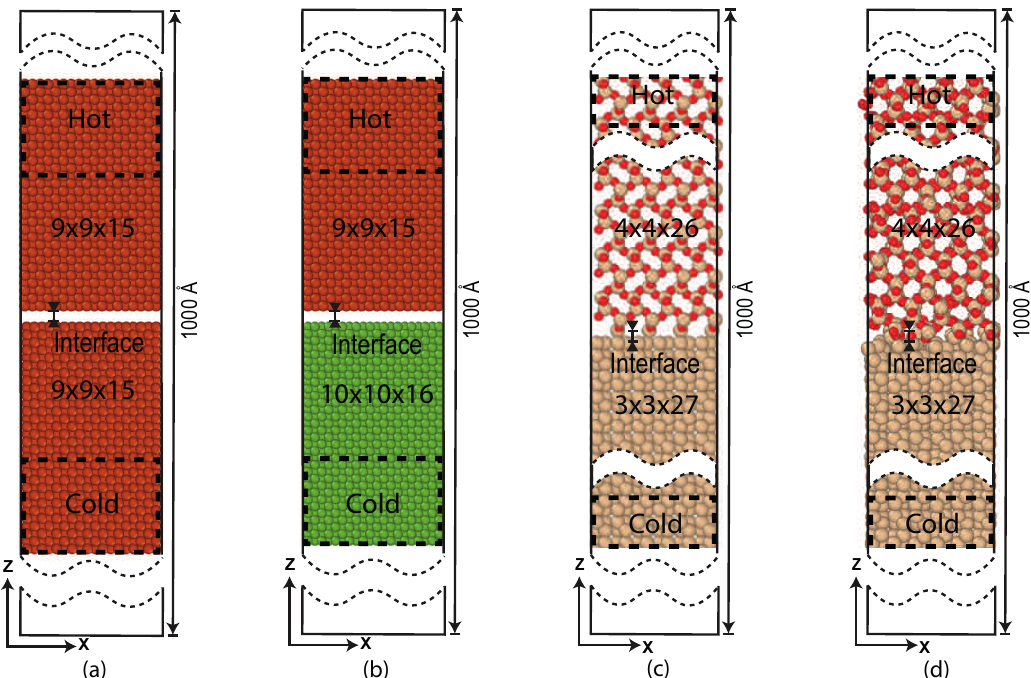
Figure 6. Schematic representation of systems: ( a ) non-reactive Pt/Pt interface, ( b ) non-reactive Pt/Ni interface, ( c ) initial reactive Si/SiO 2 interface, and ( d ) the merged reactive Si/SiO 2 interface. The particles in the dashed area are the strongly coupled sections, which acts as a heat source and heat